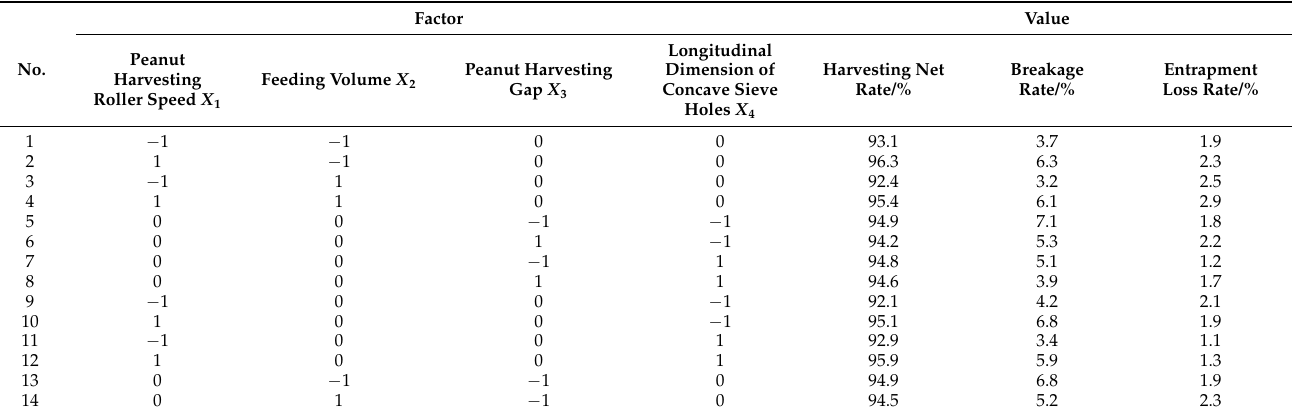
Table 3. Experiment design and response